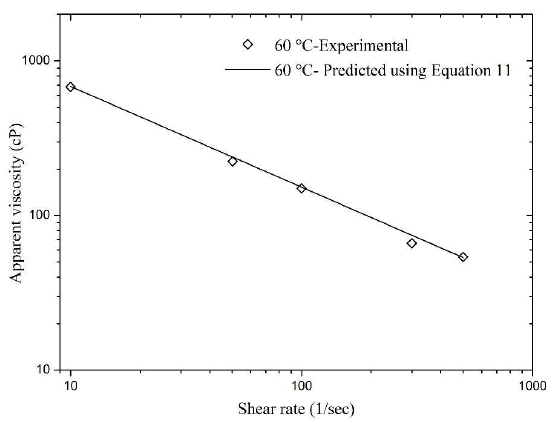
Figure 12. Validation of Equation (11) with experimental data of apparent viscosity obtained at 60 ° C.